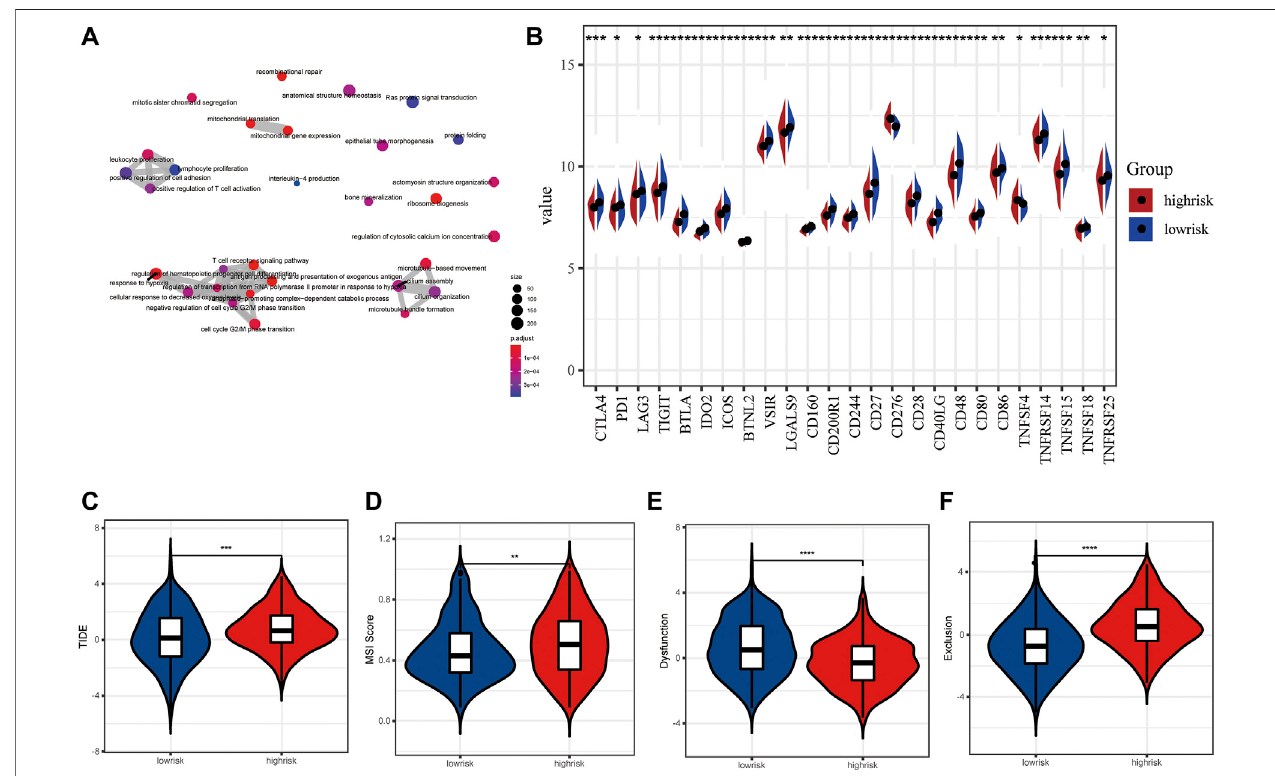
FIGURE7| Immune checkpoint inhibitors andimmunotherapybetweenhigh-andlow-riskLUADpatients. (A) Tumormutationburden betweenhigh-andlow-risk groups. (B) Tumor mutation landscape of high- and low-risk groups. (C – F) TIDE score, MSI score, dysfunction score, and exclusion score between high- and low-risk